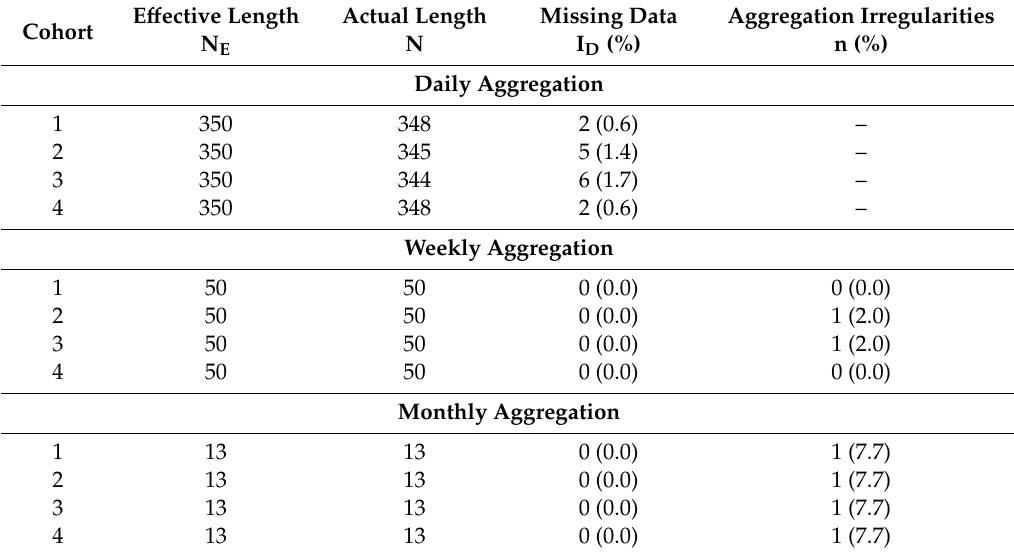
Table 2. Sample length for daily, weekly, and monthly